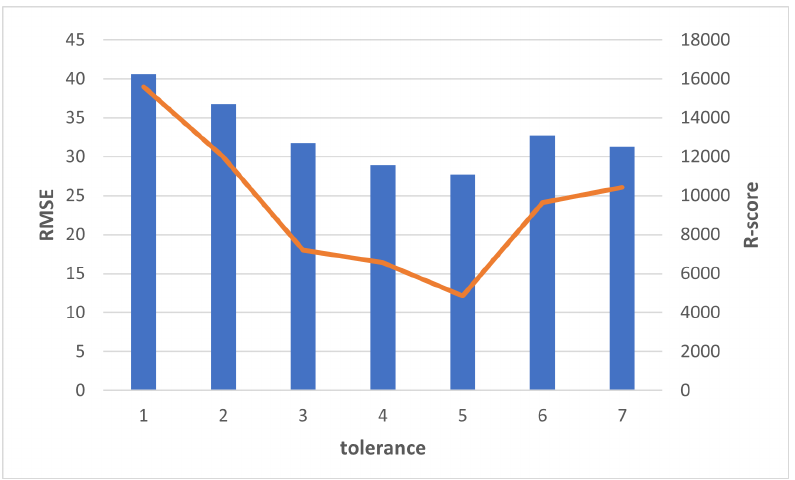
Figure 11. The effect of convolution kernel size on prediction